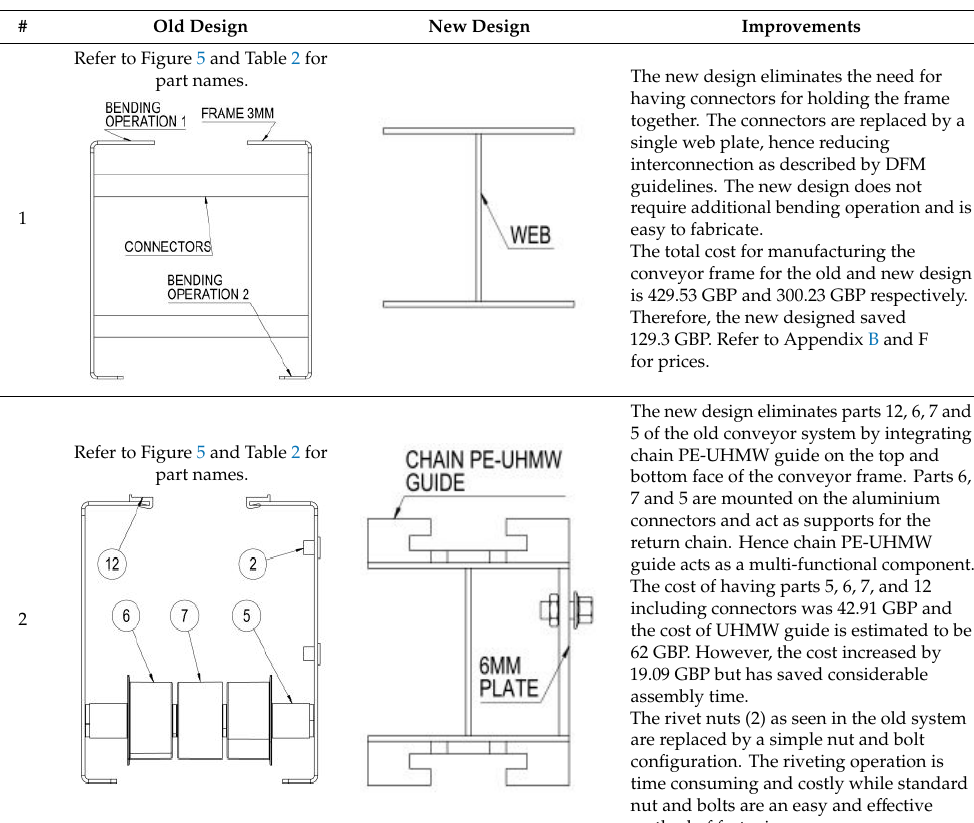
Table 7. Comparison between the old and new design.